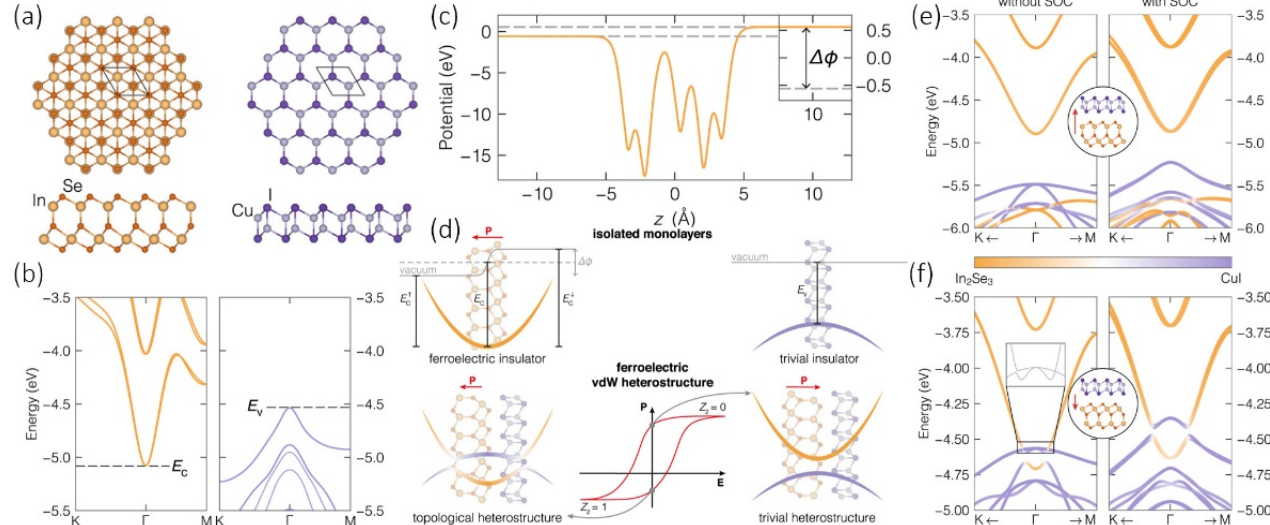
Figure 7. ( a ) Top and side views of isolated α - In 2 Se 3 (left) and DLHC CuI (right) monolayers. ( b ) Electronic band structures obtained by DFT calculations. ( c ) The electrostatic potential energy ∆𝜑 of monolayer α - In 2 Se 3 along the vertical coordinate z. ( d ) The principles of ferroelectric control of the topological property in the α - In 2 Se 3 /DLHC CuI heterostructure. The band structures with the ferroelectric polarization ( e ) upwards and ( f ) downwards. The left and right panels show the band structures obtained without and with the effect of spin-orbit coupling (SOC), respectively. Repro- duced with permission [60]. Copyright 2022, Springer Nature.